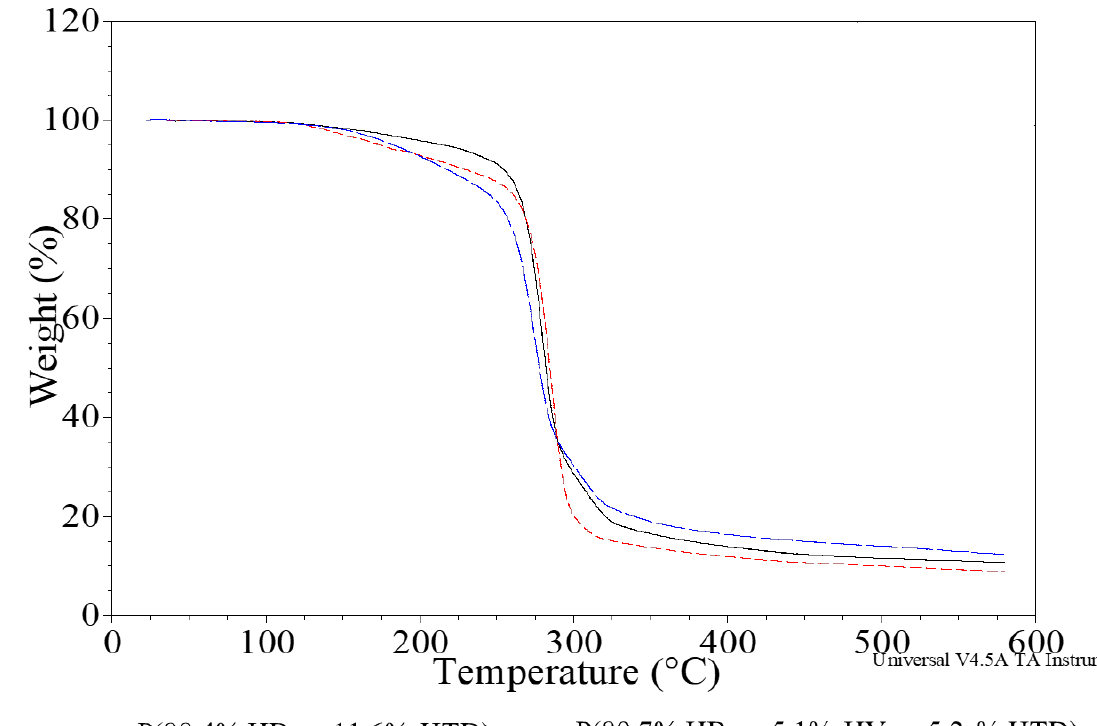
Figure 6. TGA thermograms of selected samples; ( black line ) P(88.4% HB-co-11.6% HTD) extracted from the culture supplemented with 10% SMCFAs synthetic -rich stream under nitrogen-limited condition ( red line ) P(89.7% HB-co-5.1% HV-co-5.2% HTD) extracted from the culture supplemented with 1 g/L of caproic acid under non-limited condition, ( blue line ) P(4.9% HB-co-84.0% HV-co-8.5% HtriD-co 2.6% HTD) extracted from the culture supplemented with 2 g/L of valeric acid under nitrogen-limited condition.